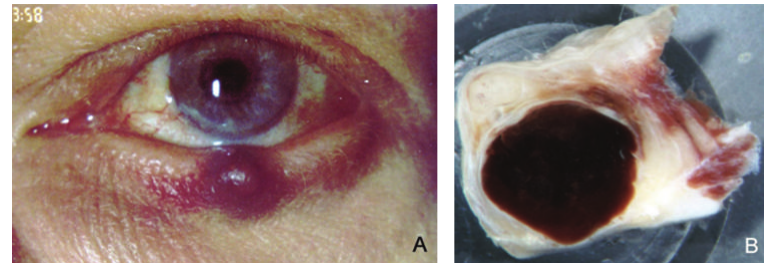
Figure 1: (A) Clinical photo with a well-circumscribed brownish nodule at the left lower eyelid. (B) Gross examination of the bisected tumor with a circumscribed dark cyst within the tarsus.